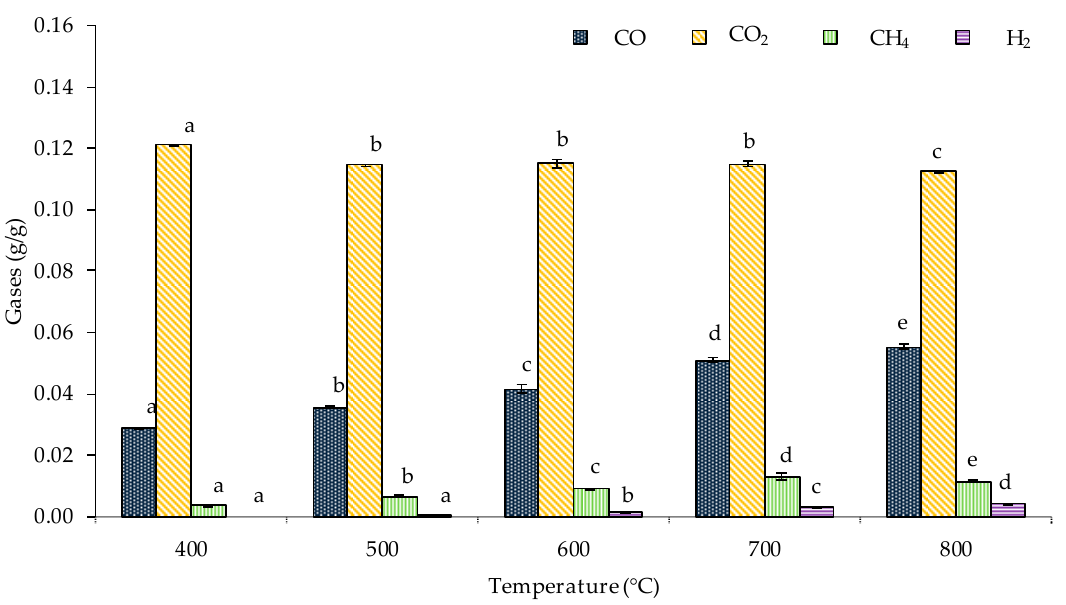
Figure 7. Gas yields as a function of pyrolysis temperature using coconut shell. Each bar is the mean ± stand error [ SE ( n = 3)]. Different letters in each specific gas bar indicate significant differences ( p ≤ 0.05).